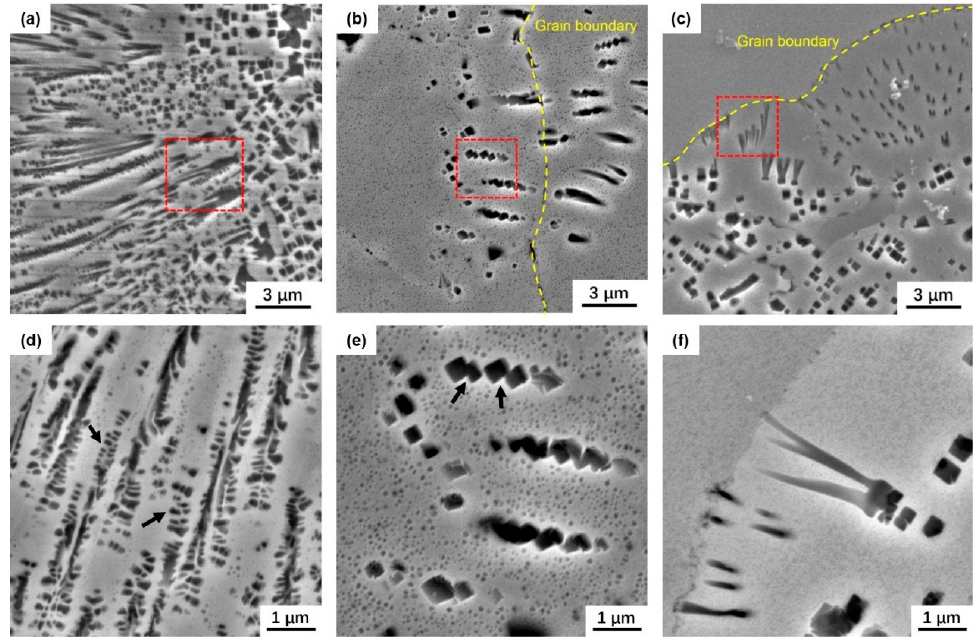
Figure 9. Microstructure of the plane perpendicular to the direction of tension: ( a , d ) Furnace cooling; ( b , e ) Air cooling; ( c , f ) Oil quenching. ( d – f ) shows the typical morphology of red frames in ( a – c ), respectively.